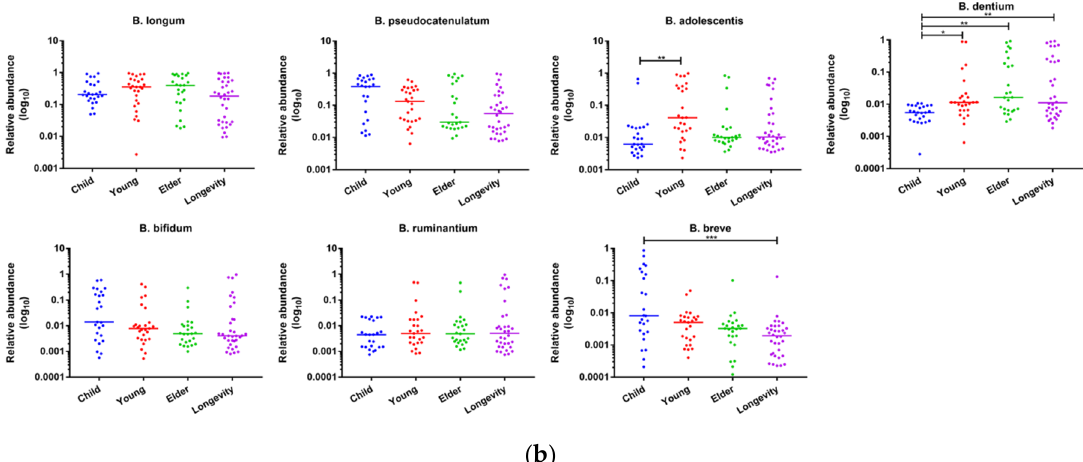
Figure 10. Composition of Bifidobacterium in samples from different regions ( a ) and across different Figure 11. Composition of Bifidobacterium in samples from di ff erent regions ( a ) and across di ff erent ages ( b ). * indicates that the difference is significant. * p < 0.05, ** p < 0.0 1 , *** p < 0.001. ages ( b ). * indicates that the di ff erence is significant. * p < 0.05, ** p < 0.01, *** p <